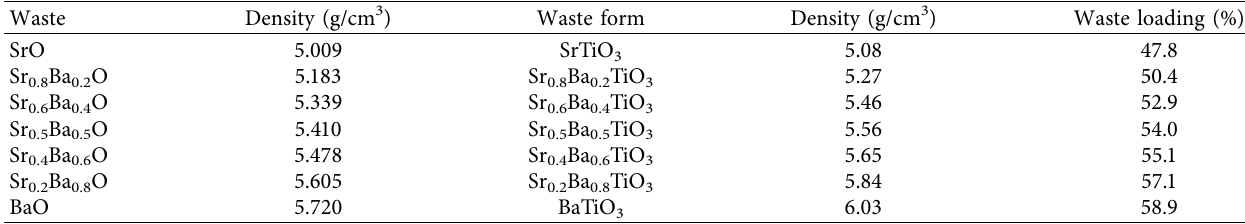
Table 3: Densities and waste loadings of Sr waste/waste form according to Sr/Ba